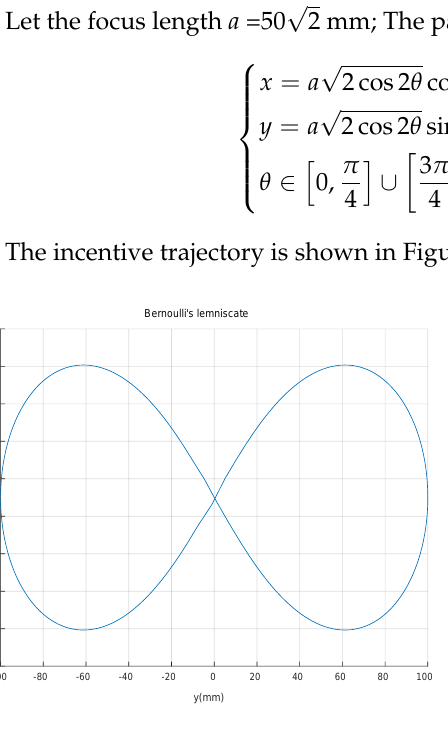
Figure 8. Incentive trajectory.